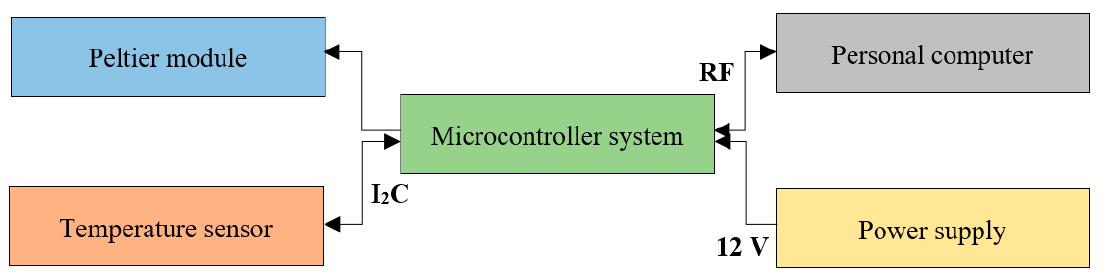
Figure 4. Block diagram presenting temperature module